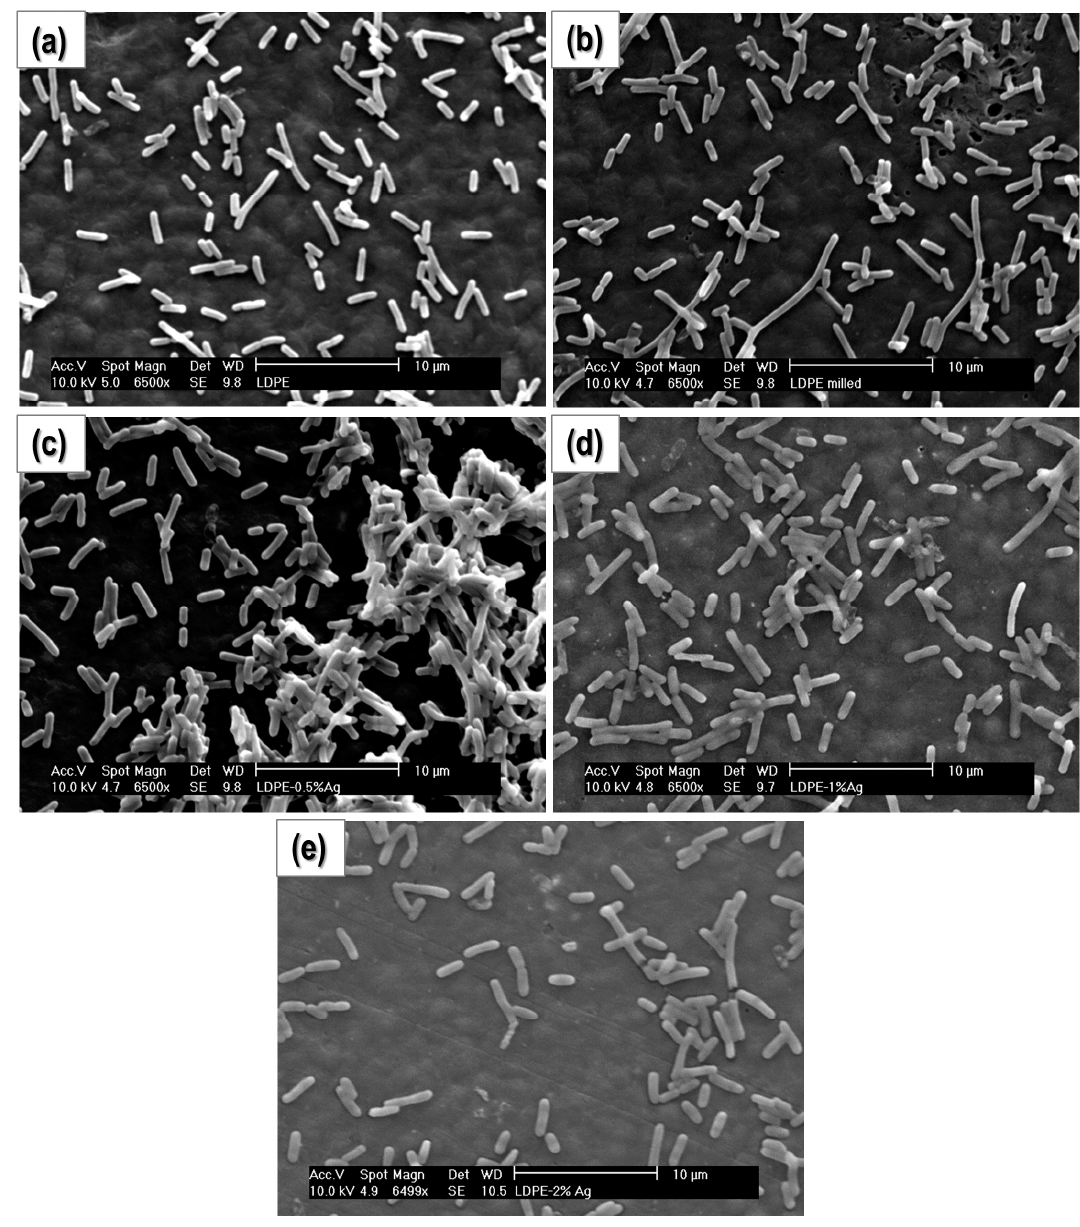
Figure 7. SEM micrographs obtained at 6500× for: ( a ) PE-Ground; ( b ) PE-Milled; ( c ) PE-0.5% Ag; ( d ) PE-1% Ag and ( e ) PE-2% Ag.